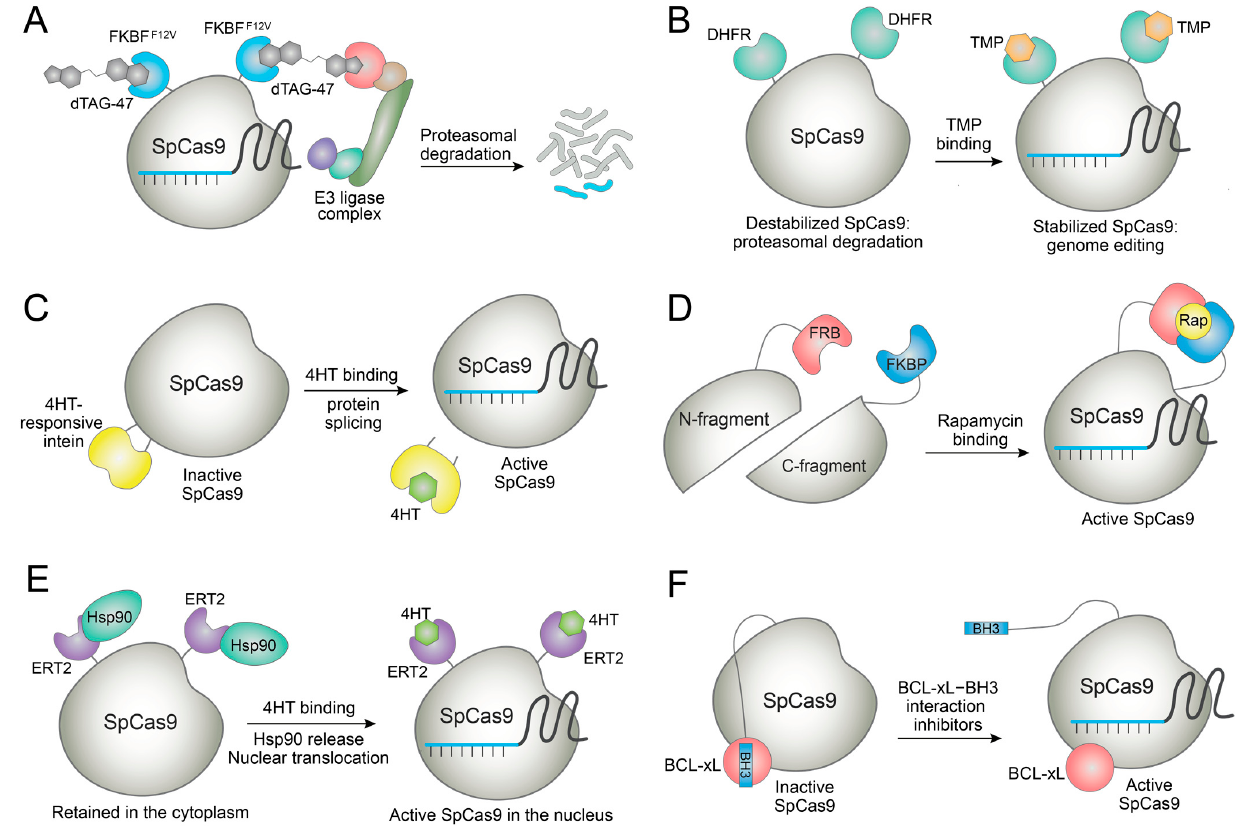
Figure 4. Examples of small-molecule control of engineered Cas nucleases. ( A ) Targeted degradation of SpCas9-FKBP F12V fusion by dTAG-47 molecule to switch off genome editing. ( B ) Destabilized SpCas9-DHFR fusion is stabilized by TMP to switch on genome editing. ( C ) SpCas9 fused to an engineered intein is spliced by binding to 4HT, and the active SpCas9 is released. ( D ) Split SpCas9 is dimerized by rapamycin to reconstitute active SpCas9. ( E ) SpCas9-ERT2 fusion in the cytoplasm is translocated to the nucleus upon binding of 4HT to the ERT domain. ( F ) SpCas9 activity is blocked by the autoinhibitory BCL-xL − BH3 interaction but restored by the inhibitors of the protein − peptide interaction.